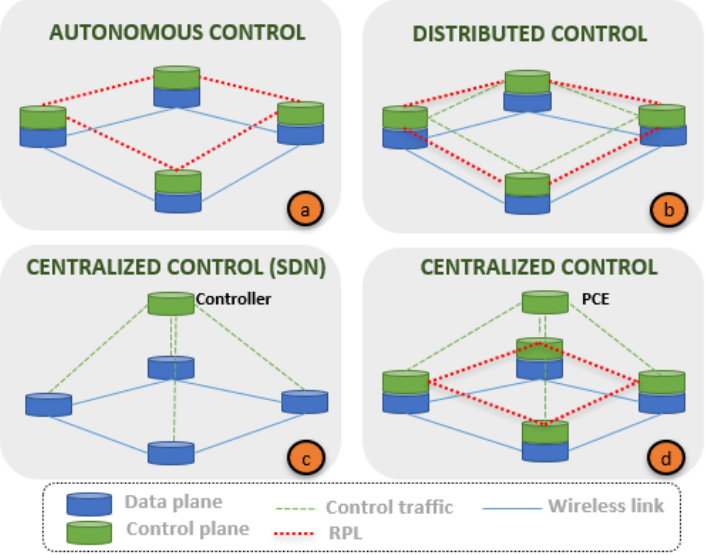
Figure 2. Control plane distribution between the main approaches of TSCH